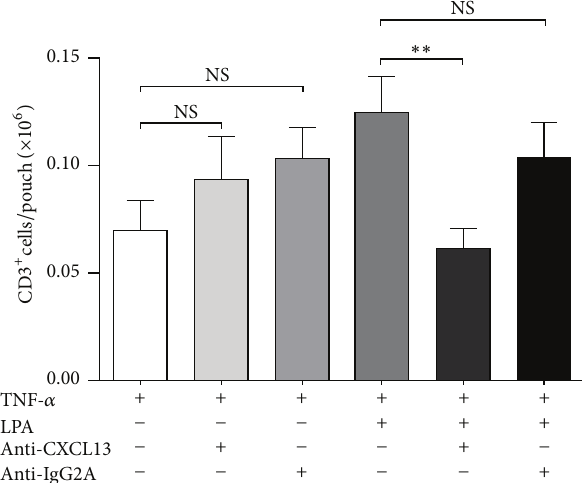
Figure 4: Effect of the CXCL13 neutralizing antibody on LPA- mediated lymphocyte recruitment into TNF- 𝛼 -primed air pouches. Air pouch tissues were pretreated with TNF- 𝛼 (50 ng) for 16h prior to administration of LPA (3 𝜇 g). Where indicated, the anti-CXCL13 neutralizing antibody or the isotype control antibody (IgG2A, 10 𝜇 g) was administered into the air pouches 15 min prior to stimulation with LPA for 4h. The absolute numbers of CD3 + T cells in air pouch lavage fluids were determined by flow cytometry as described in Section 2. Data are the mean ± SE of at least 5 mice/group. ∗∗ 𝑃 < 0.01 by analysis of